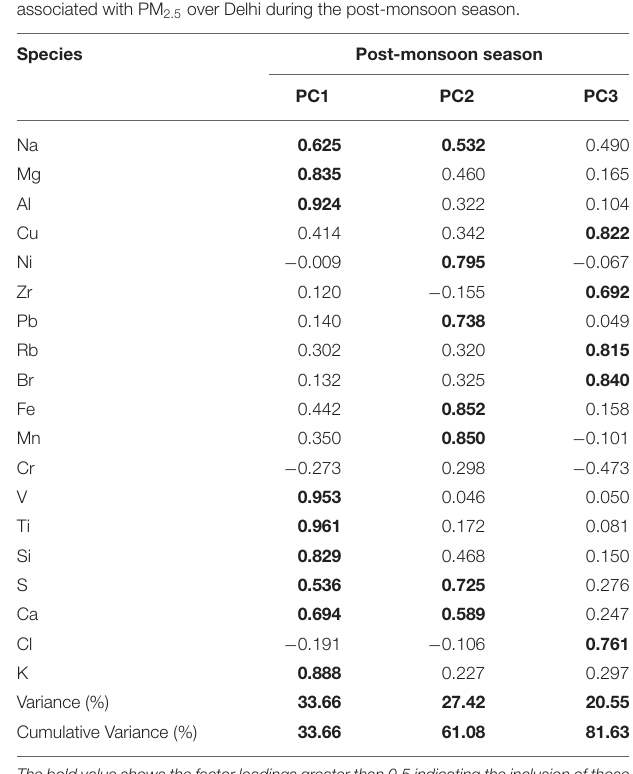
TABLE 1 | Summary of principal component analysis (PCA) of elements associated with PM 2.5 over Delhi during the post-monsoon